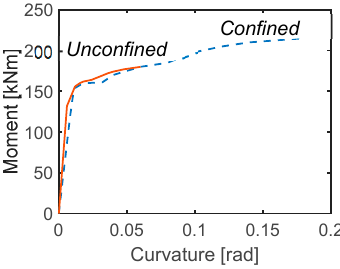
Figure 17. Bending moment-curvature diagram for C1 column referred to its strong flexural axis.